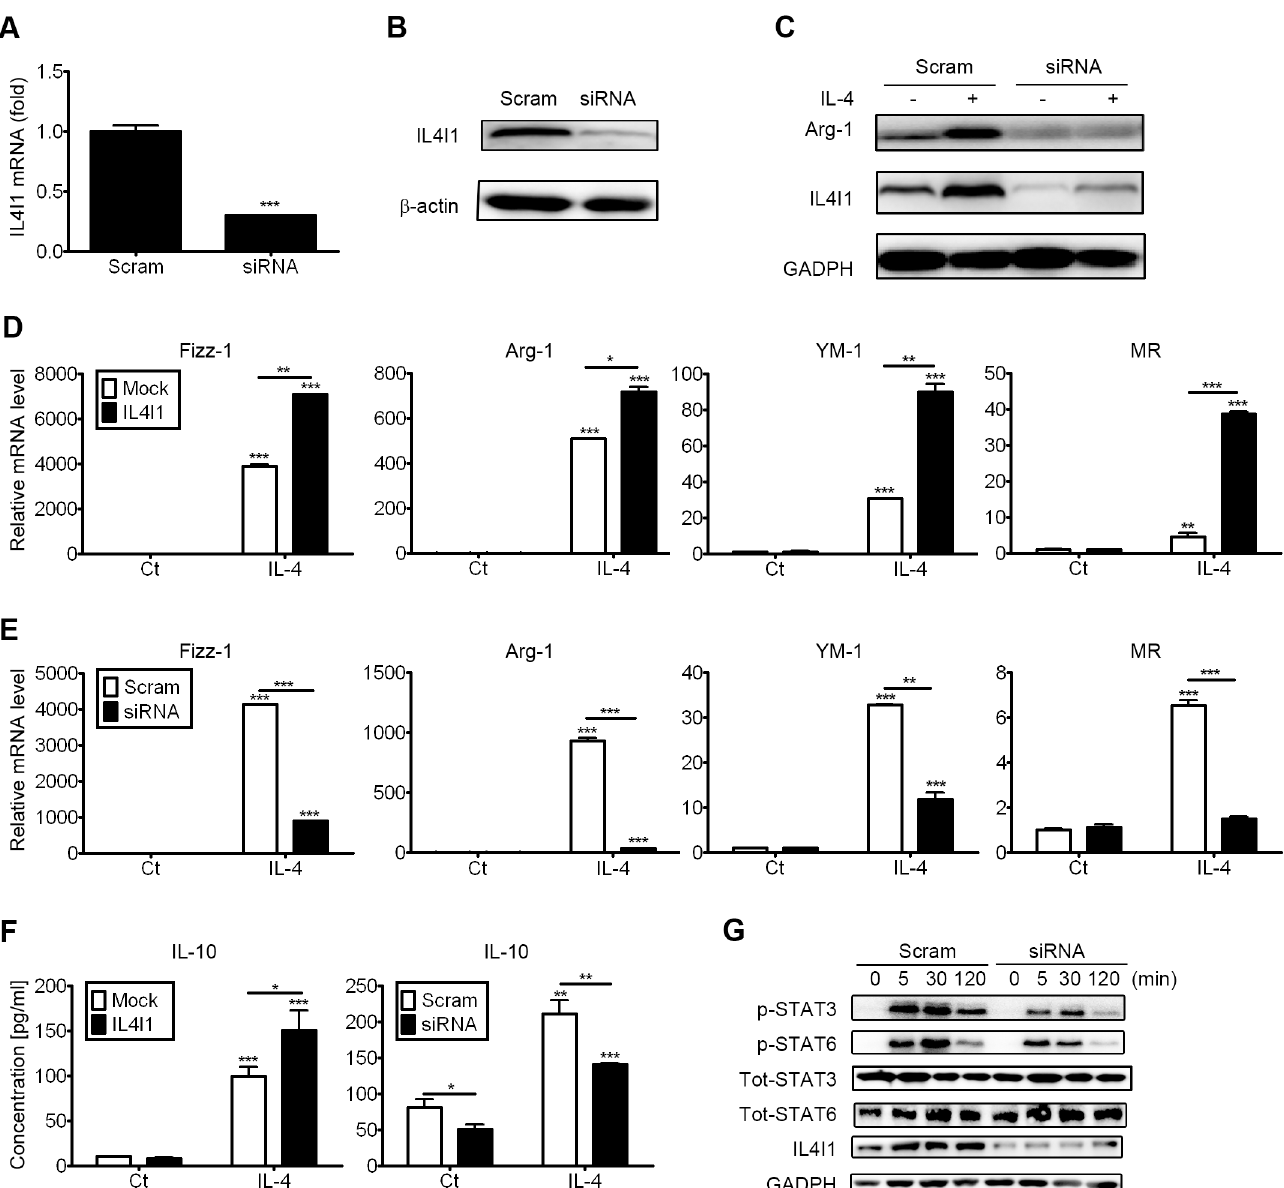
Fig 3. IL4I1 promotes M2 macrophage phenotypes. BMDMs were transfected with siRNA to target IL4I1 or with scrambled siRNA for 24 h. The silencing efficiency was evaluated by q-PCR (A) and western blotting (B), respectively. Representative data are presented as means ± S.D. of three independent experiments. Significance was calculated by one-way ANOVA with multiple comparison post test (Bonferroni). Asterisks indicate significant differences compared to scrambled siRNA transfections; *** p < 0.001. BMDMs were transfected with siRNA against IL4I1 or scrambled siRNA for 24 h, and then were treated with IL-4 (20 ng/mL) or were untreated for 24 h. Expression of Arg-1 and IL4I1 was assayed by western blotting (C) and IL-10 expression was assayed by ELISA (F). The gene expression levels of the M2 markers Fizz-1, Arg-1, YM-1, and MR were assayed by q-PCR (E). BMDMs were infected with IL4I1-encoding recombinant retrovirus or control, then were treated with IL-4 (20 ng/mL) or were untreated for 24 h. Levels of gene expression for the M2 markers Fizz-1, Arg-1, YM-1, and MR were assayed by q-PCR (D) and IL-10 expression was assayed by ELISA (F). Representative data are presented as means ± S.D. of four independent experiments. Significance was calculated by one-way ANOVA with multiple comparison post test (Bonferroni). Asterisks indicate statistically significant differences, either compared to controls, or between two conditions that are linked by a bar ( * p < 0.05, ** p < 0.01, *** p < 0.001). BMDMs were stimulated with IL-4 (20 ng/mL) or left untreated for 5, 30, or 120 min. The phosphorylation state of STAT-3 and STAT-6 was assessed by western blotting (G); blots are representative of four experiments. Total STAT-6, total STAT-3, and GADPH were used as loading